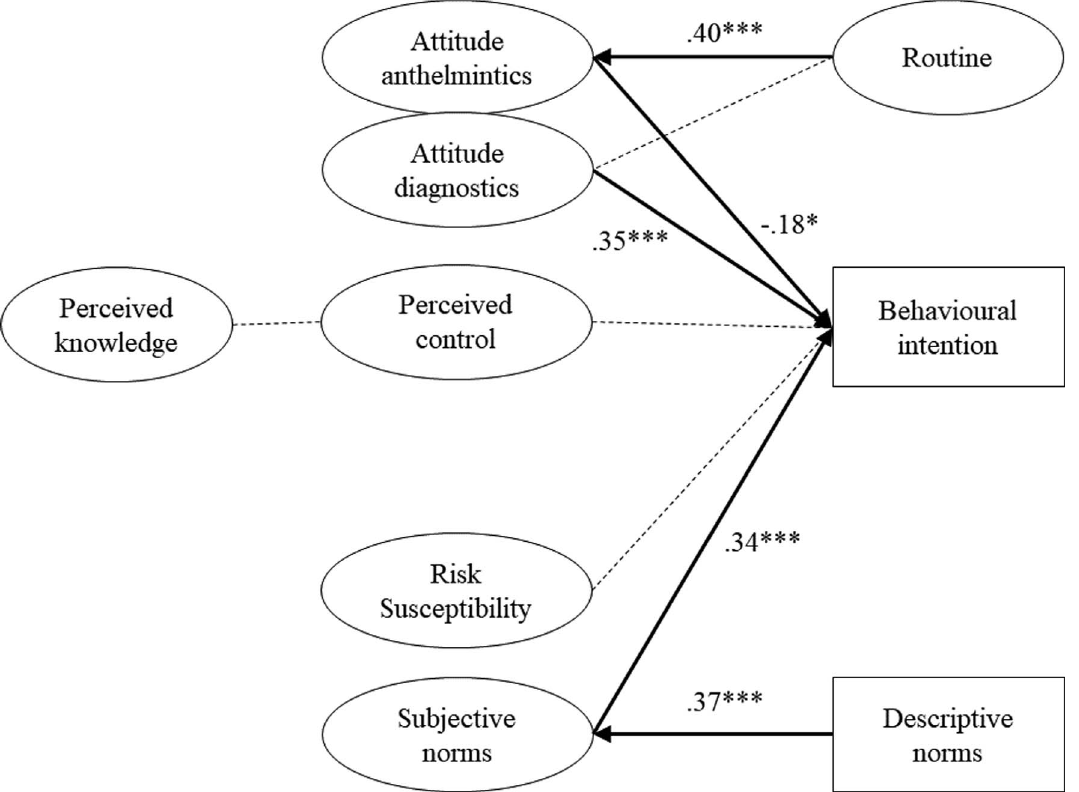
Figure 4. Structural equation model predicting dairy farmers ’ adoption of diagnostic methods for control of gastrointestinal nematode infections in Austria and Germany (N = 267). Notes. Full lines represent the signi fi cant equations with the numbers representing standardized regression coef fi cients, dotted lines represent insigni fi cant equations. *** p < 0.001, ** p < 0.01, * p < 0.05. Variables represented by a rectangle consist of a one-item measurement; variables represented by an oval consist of a multi-item